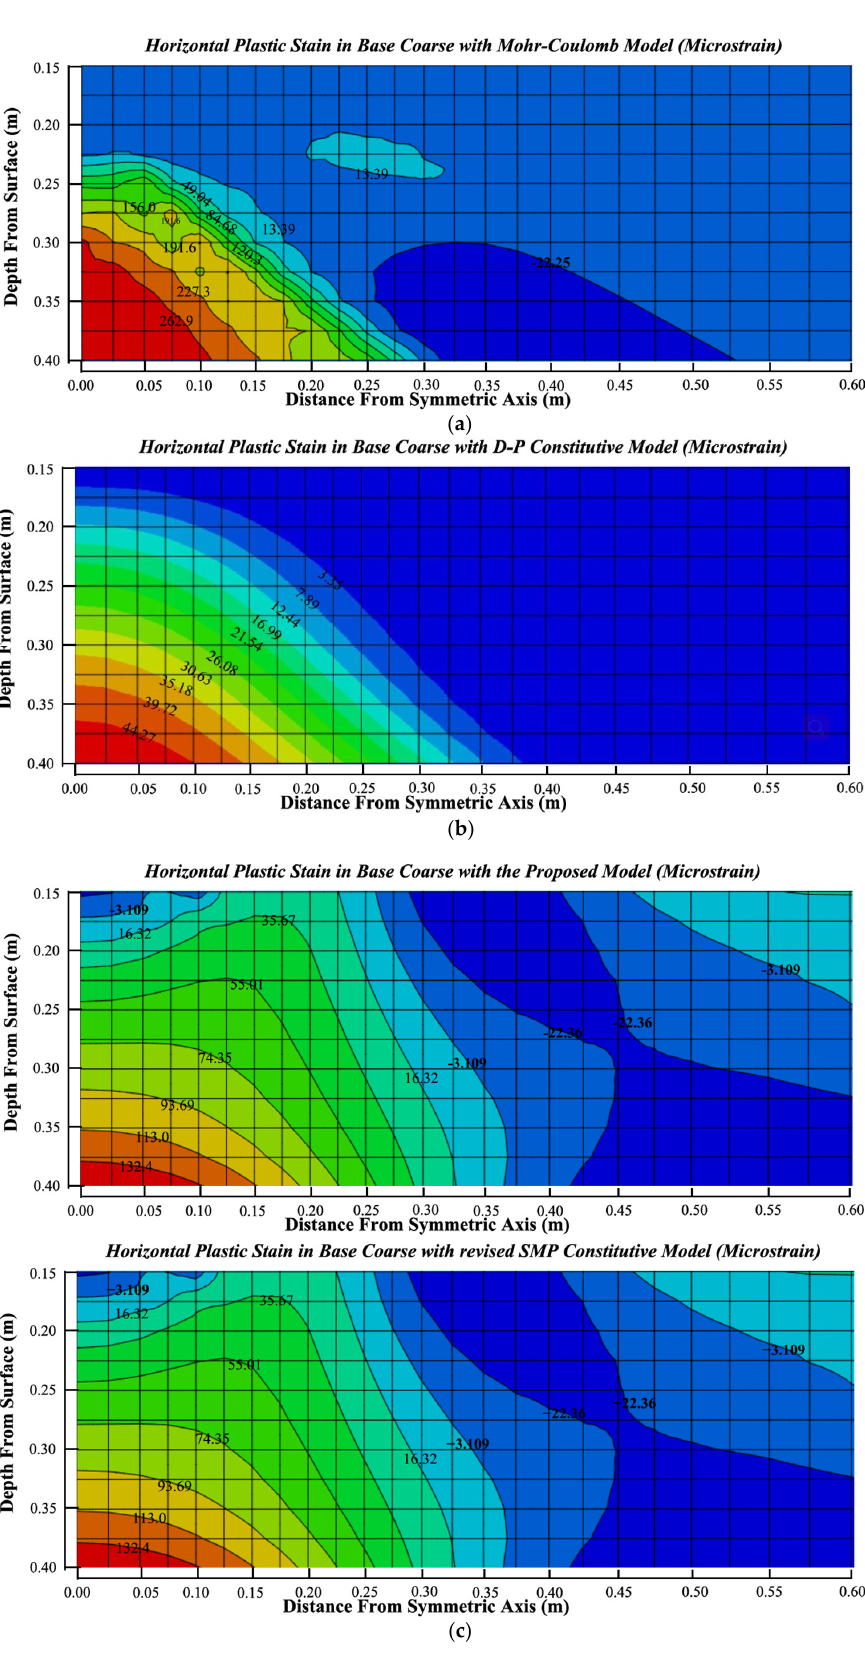
Figure 4. Distribution of horizontal nominal plastic strain of UGM layer with the three models ( a ) Mohr-Coulomb model, ( b ) Druck-Prage model, ( c ) revised SMP model.